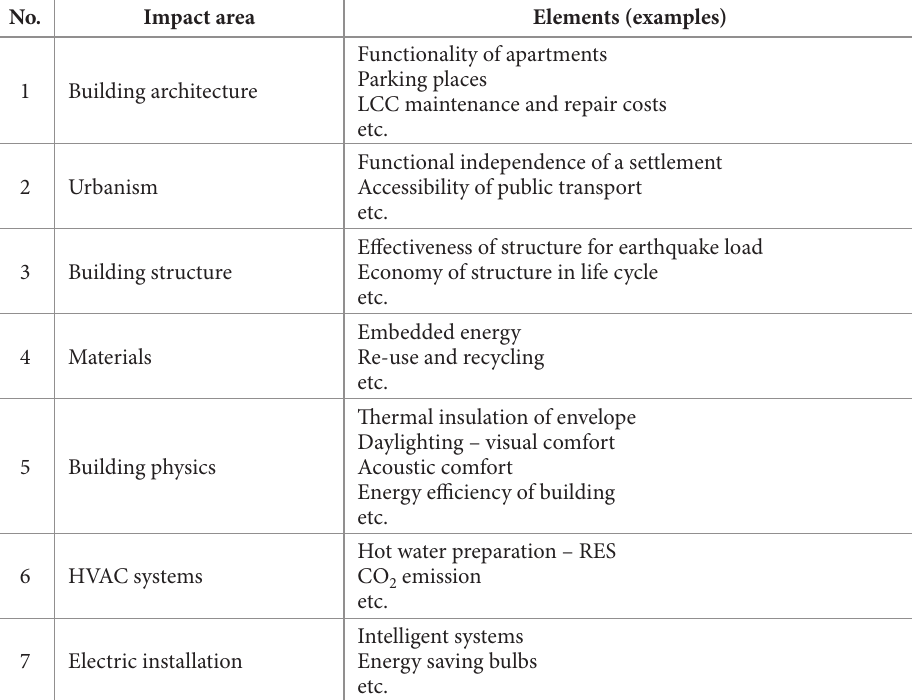
Table 1. Impact areas and examples of elements that influence building sustainability No. Elements